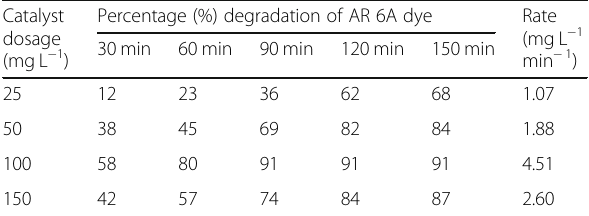
Table 6 Effect of catalyst loading on the rate of degradation